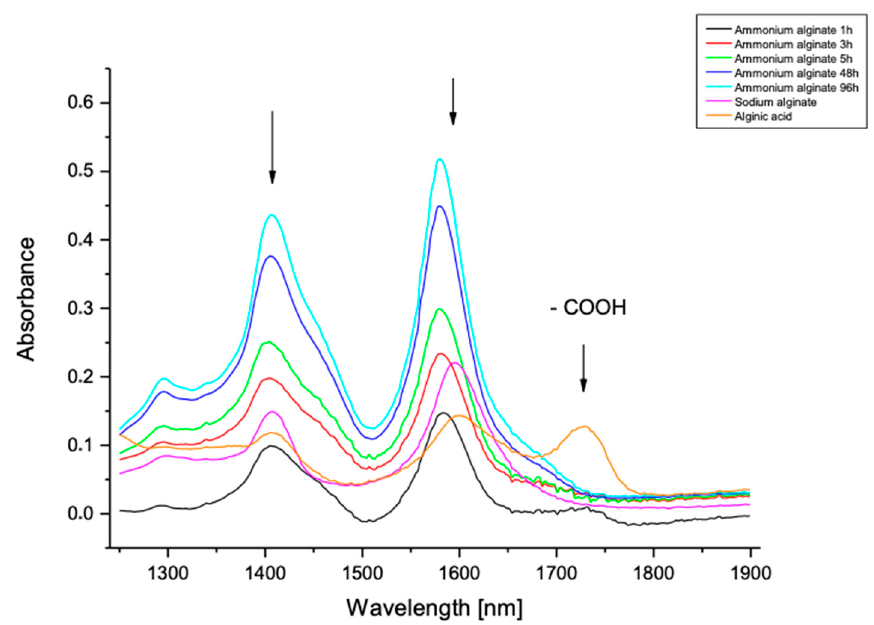
Figure 2. A fragment of the FTIR ATR spectrum of sodium alginate, alginic acid, and ammonium alginate, produced by the modification of alginic acid in an ammonia atmosphere in the selected